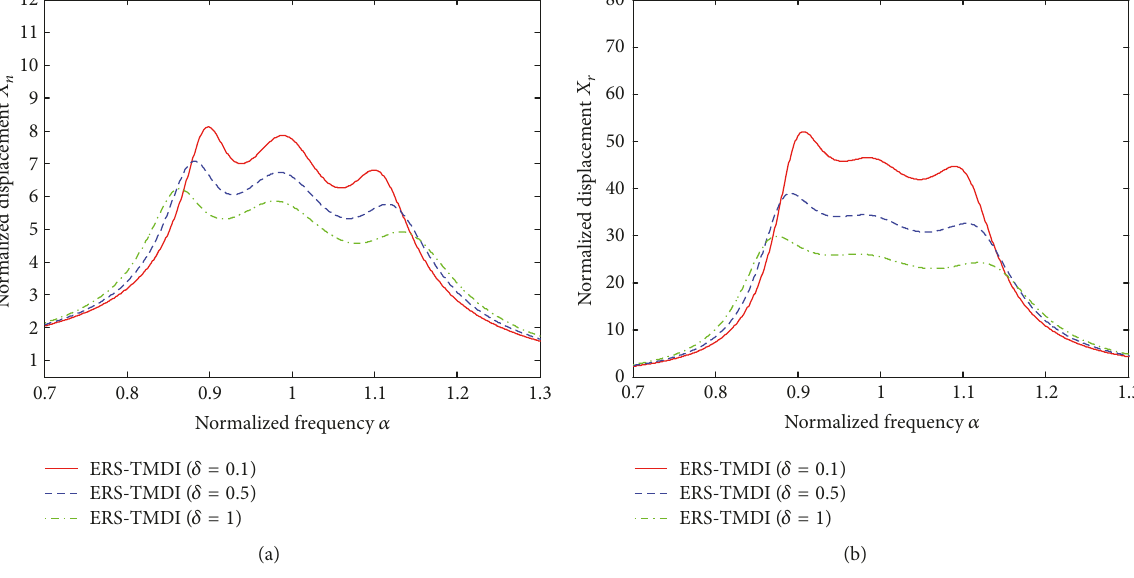
Figure 5: Schematic of the optimal frequency responses under different inertance ratio: (a) the deformation of the primary structure and (b) the relative deformation of the